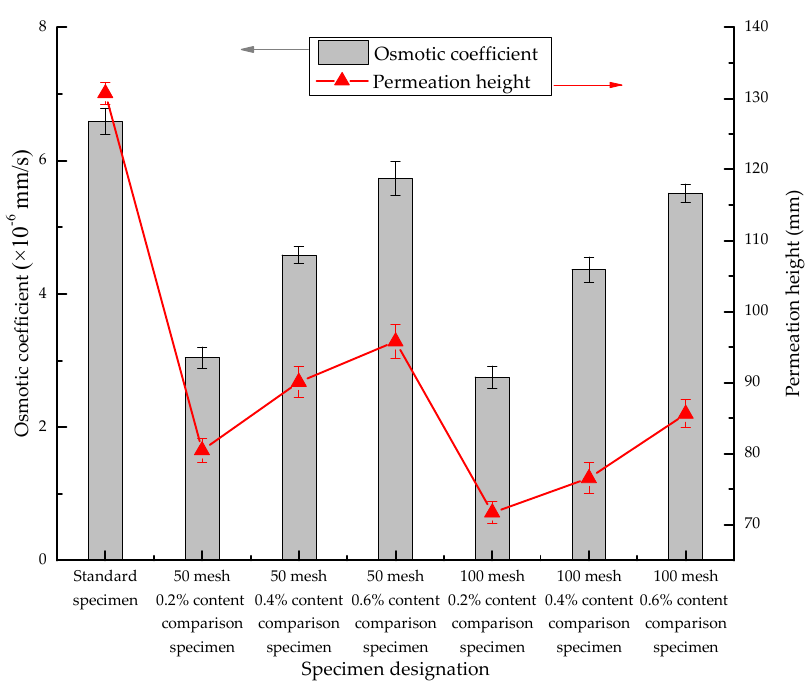
Figure 5. Relationship between osmotic coefficient Kr and permeation height.